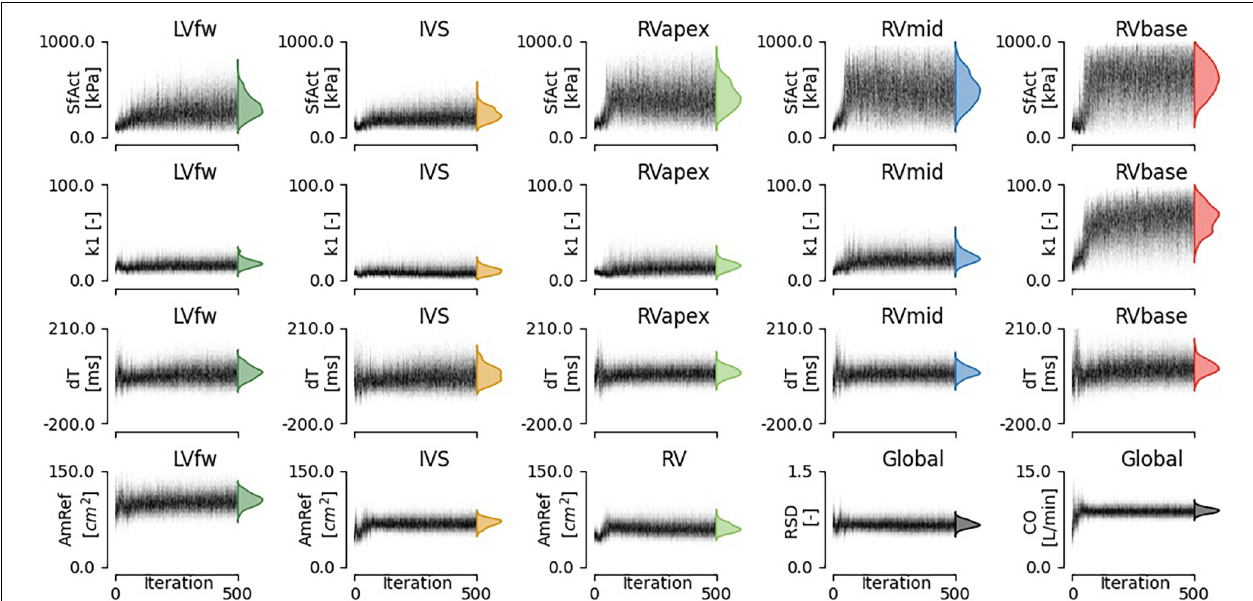
FIGURE 4 | Convergence of estimated model parameters. The distributions on the right show the final estimated posterior